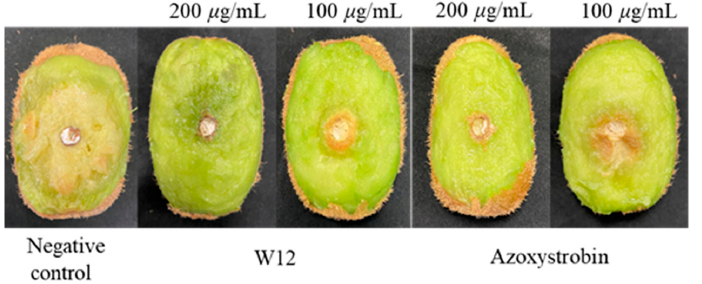
Figure 5. Protective activity of W12 and azoxystrobin against Phomopsis sp. on kiwifruit.